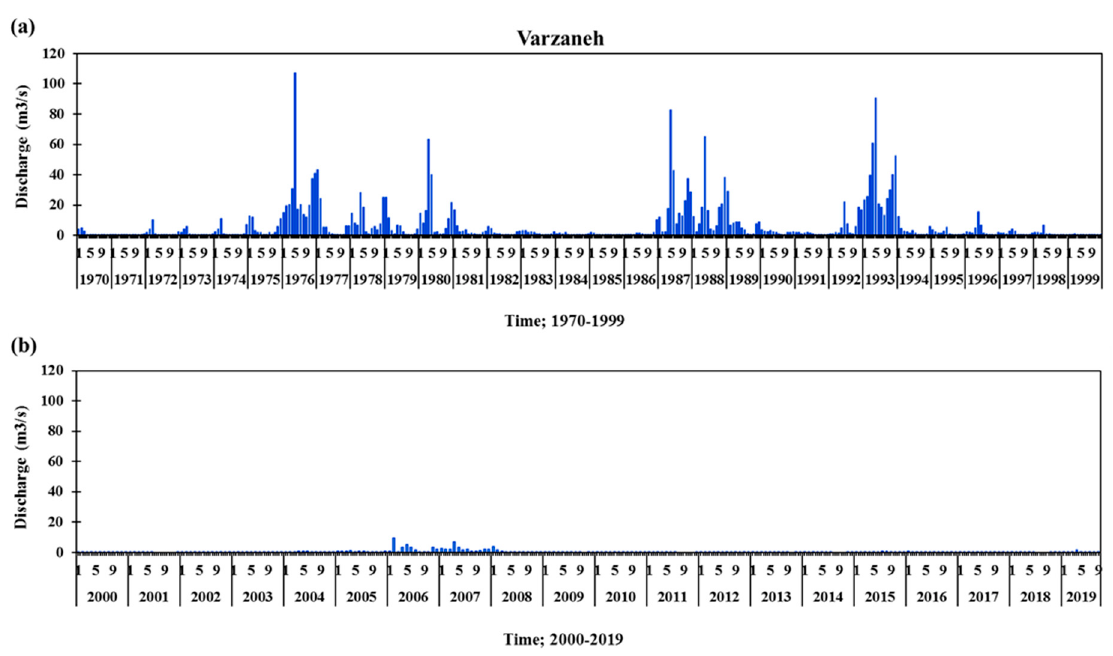
Figure 5. Monthly time series of discharge at Varzaneh hydrometric station: ( a ) 1970–1999; ( b ) 2000–2019.